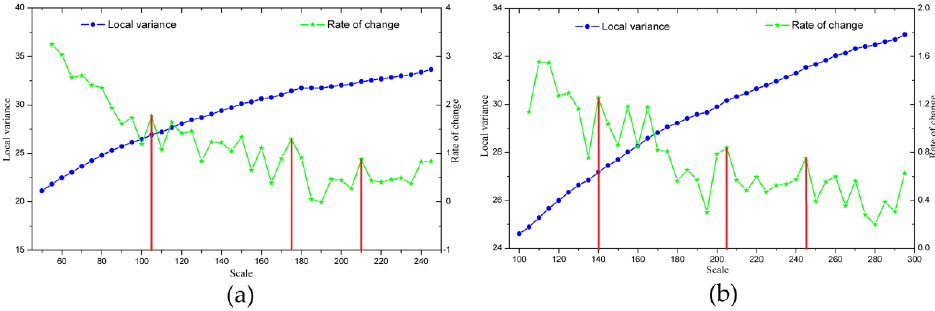
Figure 8. Curves showing that LV and ROC-LV vary as functions of scale. ( a ) DS1; ( b ) DS2.